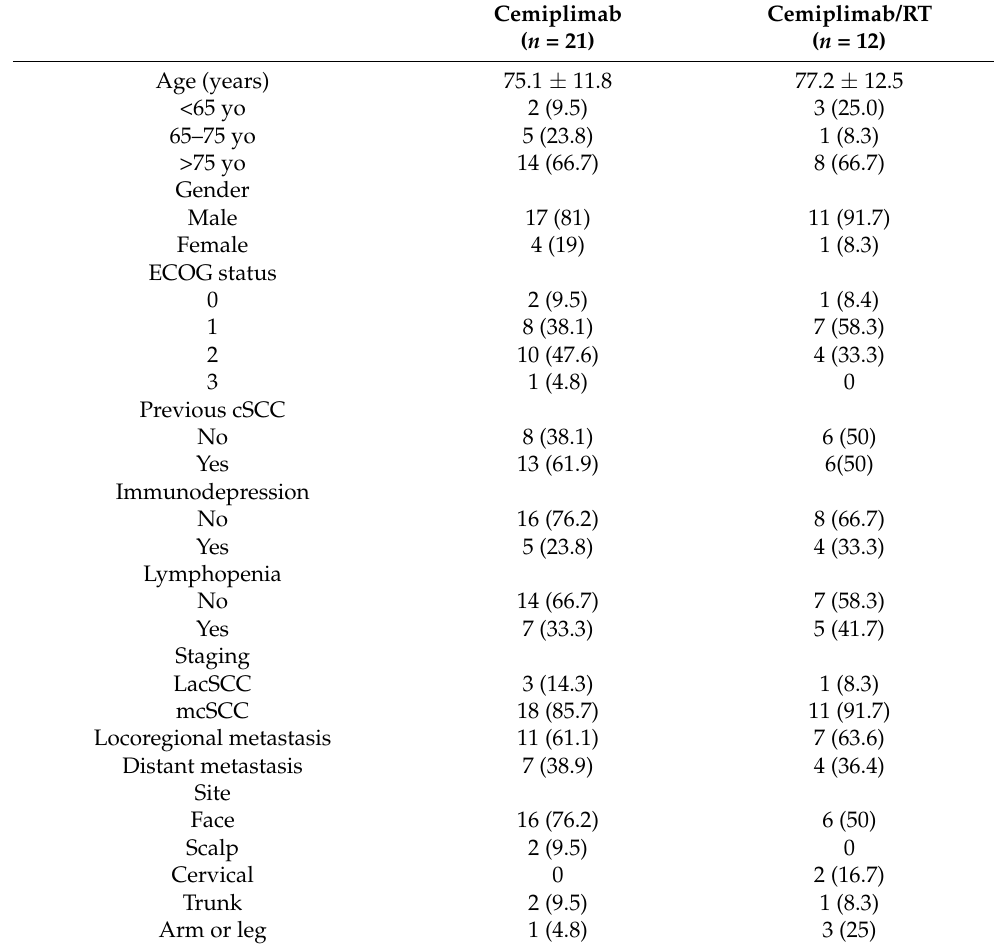
Table 1. Patient